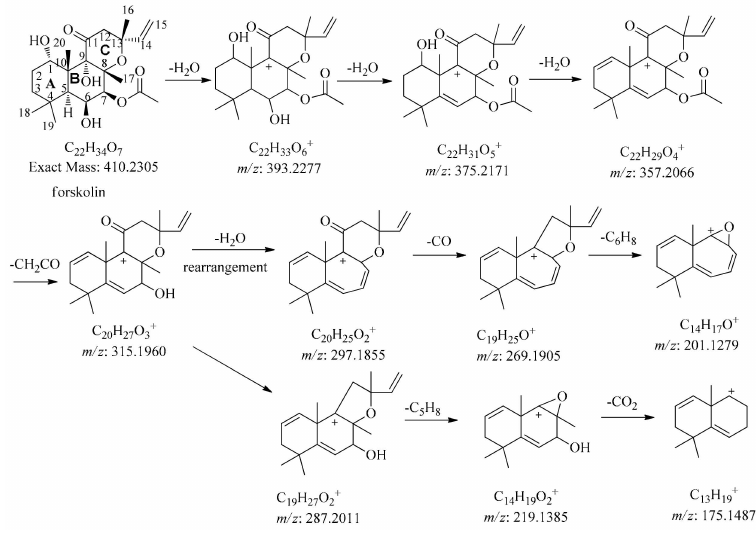
Figure 7. Proposed fragmentation pathway of